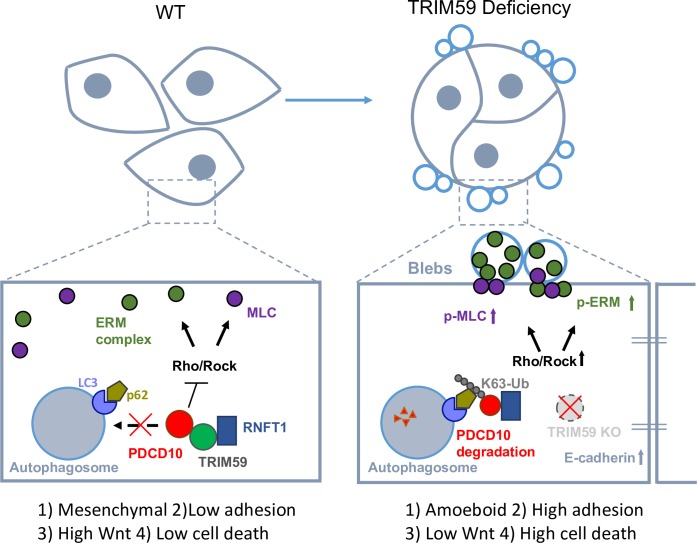
TRIM59 depletion attenuates breast cancer cell survival and metastasis.TRIM59 is essential for breast cancer cell mesenchymal movement and cell survival by maintaining low cell adhesion and high Wnt signaling of breast cancer cells. TRIM59 stabilizes PDCD10 by inhibiting K63 ubiquitination induced by RNFT1 at the lysine 179 site, and subsequently suppresses p62-selective autophagy degradation. TRIM59 deficiency facilitates PDCD10 degradation to overcome its inhibitory effect on Rho/ROCK signaling, thereby causing hyperactivated MLC and ERM and mesenchymal to amoeboid transition (MAT). TRIM59 deficiency also promotes excessive E-cadherin expression and reduces β-catenin expression, leading to high cell adhesion, low Wnt signaling, and high cell death to ultimately curtail tumor formation and metastasis. ERM, Ezrin (Thr567)/Radixin (Thr564)/Moesin (Thr558); KO, knockout; K63-Ub, lysine 63-linked polyubiquitin; LC3, microtubule-associated protein 1A/1B-light chain 3; MAT, mesenchymal to amoeboid transition; MLC, myosin light chain; PDCD10, programmed cell death protein 10; p-ERM, phosphorylation of ERM; p-MLC, phosphorylation of MLC; p62, phosphotyrosine-independent ligand for the Lck SH2 domain of 62 kDa; Rho/ROCK, Ras homolog/Rho-associated coiled-coil kinase; RNFT1, RING finger and transmembrane domain-containing protein 1; TRIM59, tripartite motif 59; Ub, ubiquitin; WT, wild-type.